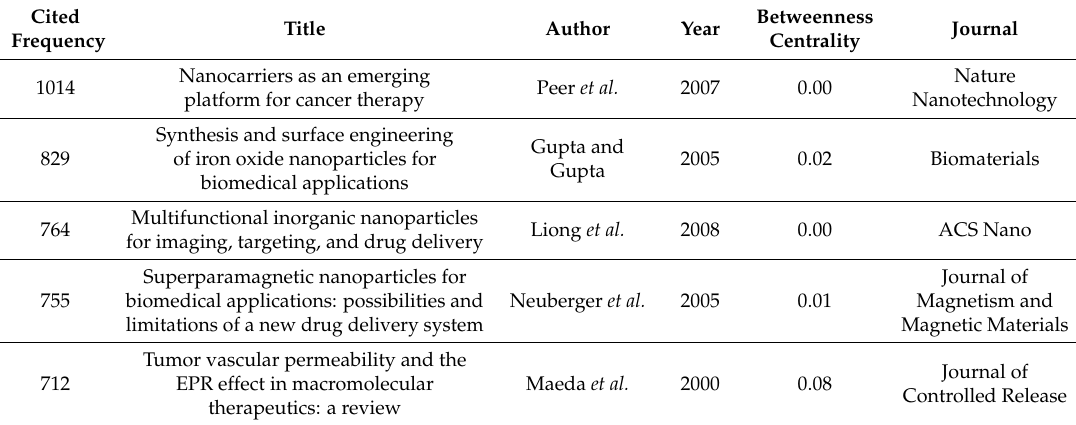
Table 1. Five critical articles in nanoparticle drug delivery technologies.